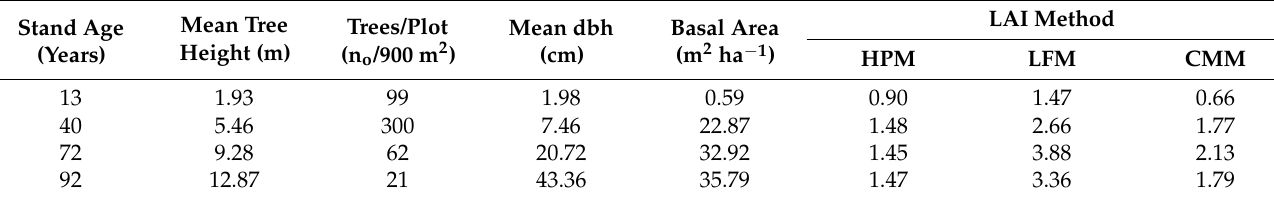
Table 3. Variation in stand structure across the study plots. Leaf Area Index (LAI) was estimated with three different methods (see text for details). Diameter at breast height (dbh) measured for trees with a diameter > 1 cm. Hemispherical Photography method (HPM), Litterfall method (LFM) and Ceptometer Method (CMM).